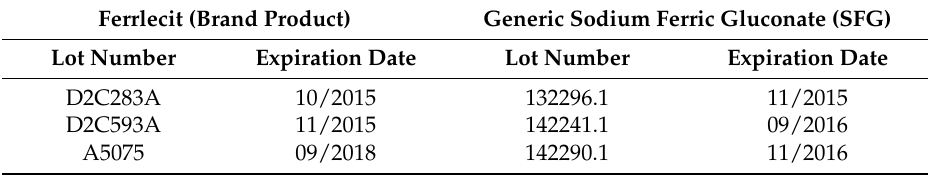
Table 1. Lot number and expiration date of Ferrlecit and the generic product of sodium ferric gluconate (SFG) complex in sucrose injection used in this study. Date: